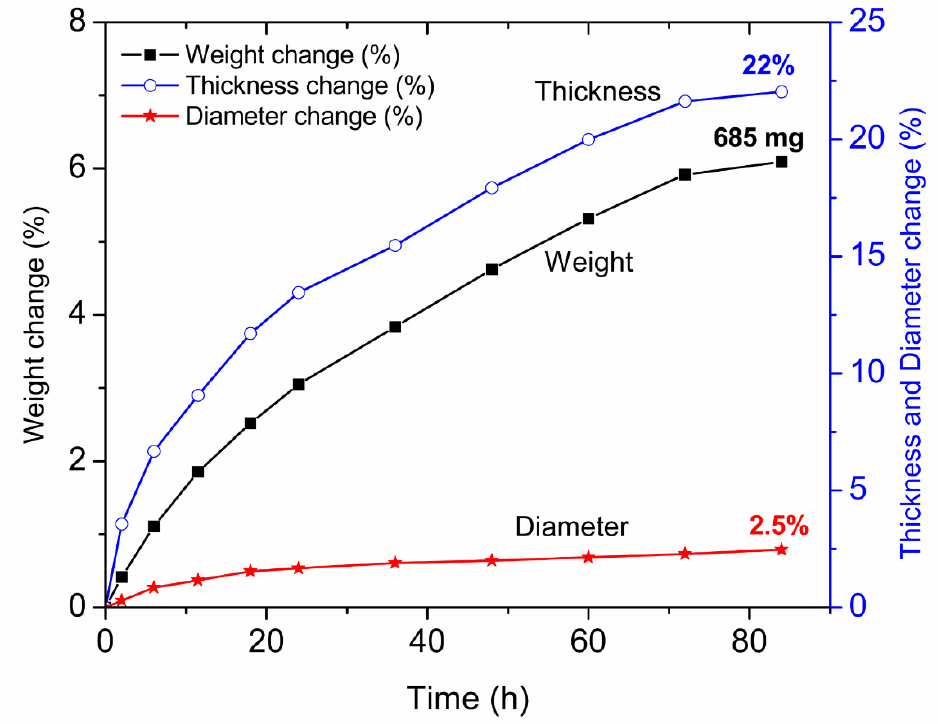
Figure 5. Measured weight and geometry change of an uncoated sample as a function of conversion time.